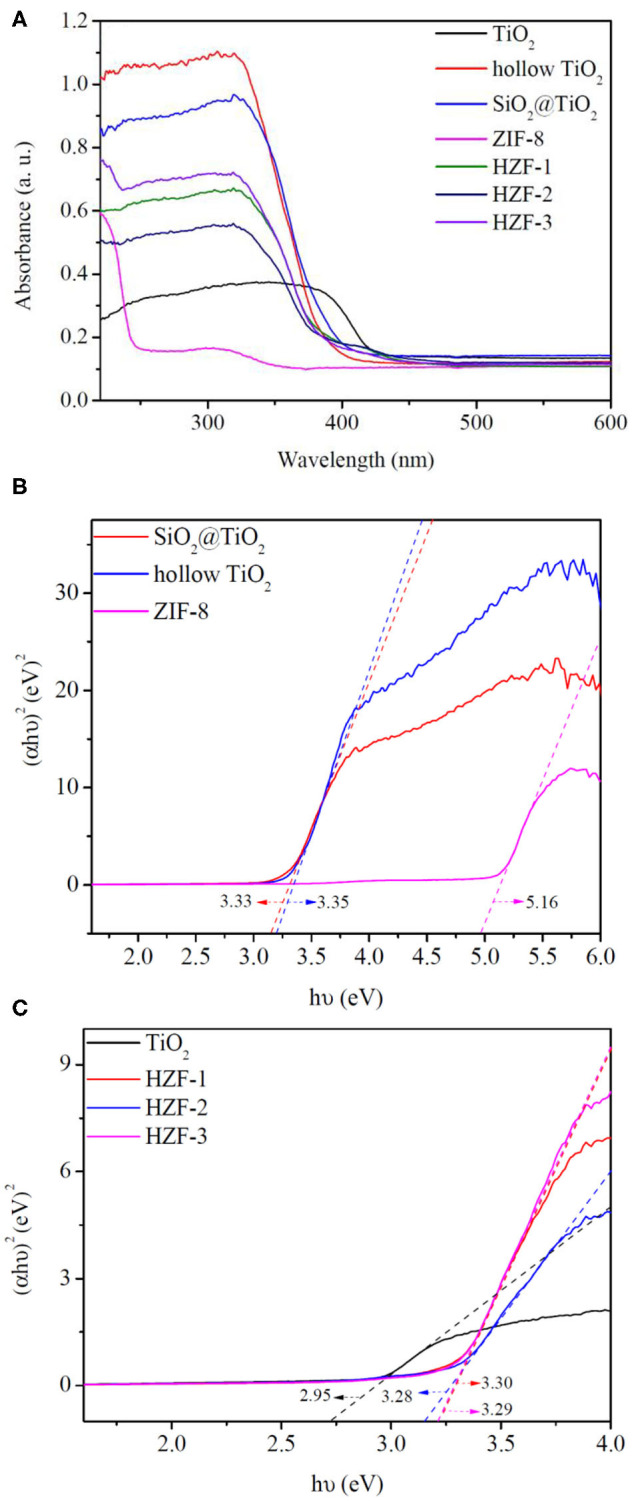
(A) UV-visible absorption spectra of the synthesized nanoparticles. (B,C) Fit curves of Tauc plot for band gap of the synthesized nanoparticles.